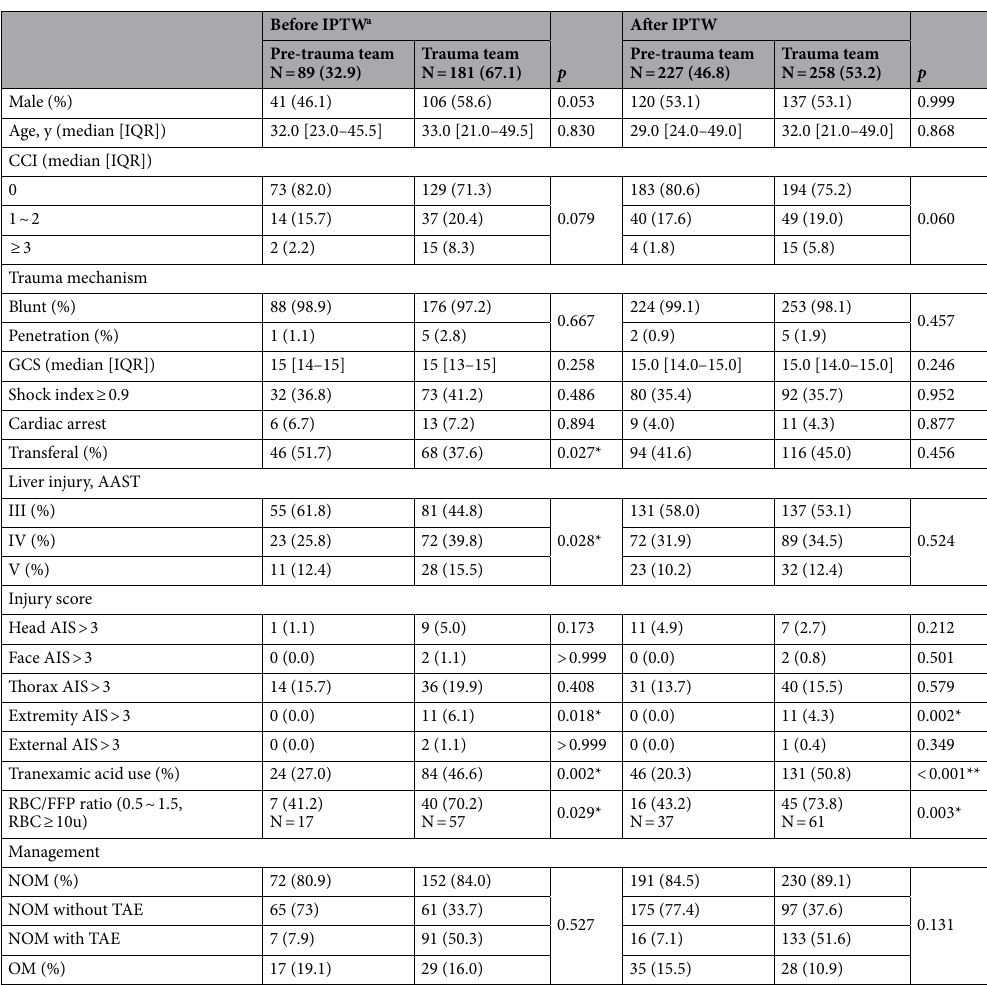
Table 1. Initial characteristics. AIS abbreviated injury scale; CCI Charlson comorbidity index; ISS injury severity score; NOM non-operative management; OM operative management; TAE transarterial